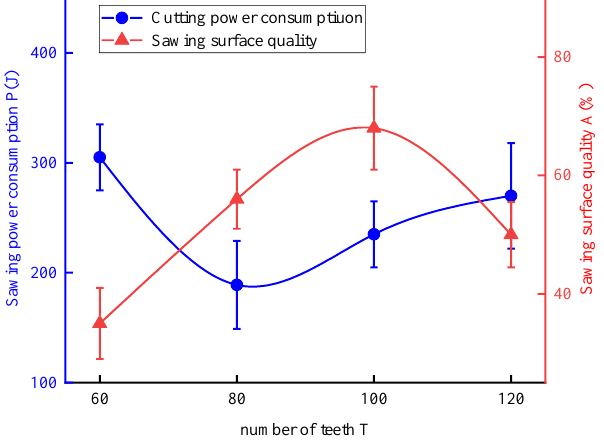
40 m/s; cutting inclination 10°; number of teeth 80; moisture content 24.7~28.3% ).